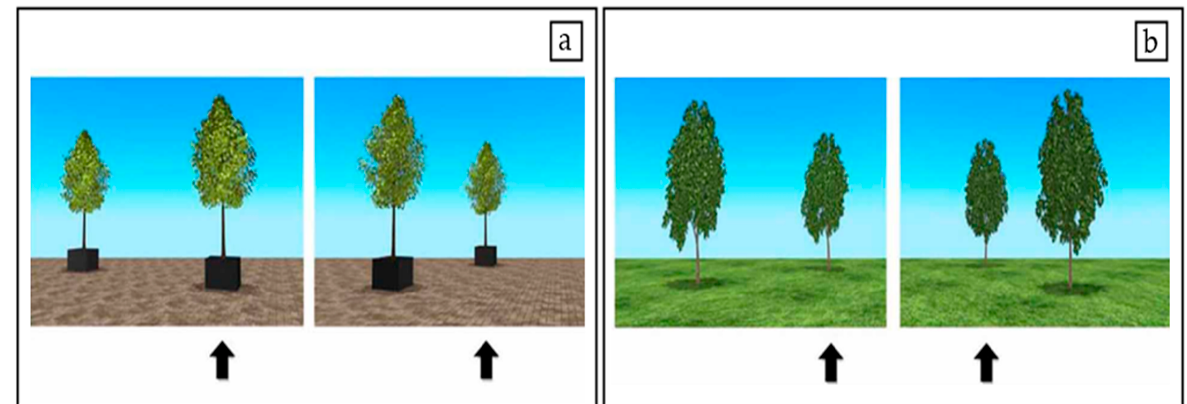
Figure 2. Experimental conditions of the spatial cognition task. The stills from the experimental movie depict the two trial types included in the present study. In side-congruent trials (SCon, panel a ) the initial and final target position are on the same side of the participant’s body. In side-incongruent trials (SInc, panel b ), the initial and final target position are on the opposite side of the participant’s body. Reliance on egocentric coding to respond on SInc trials results in below chance performance. (Image and caption adapted from [32]).